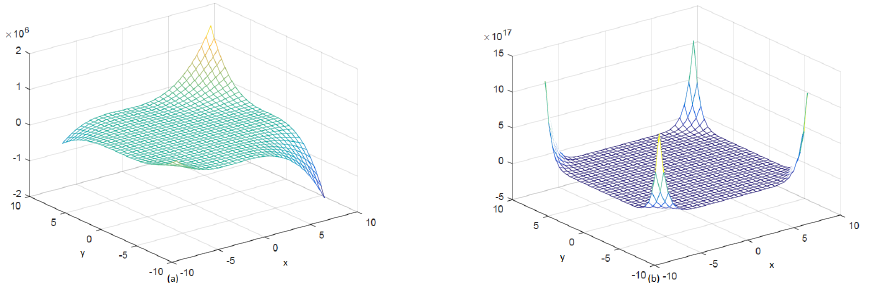
Figure 3: Plotting of (a) M-polynomial and (b) NM-polynomial of